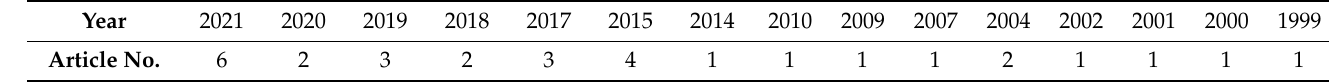
Table 4. Number and years corresponding to journal articles.